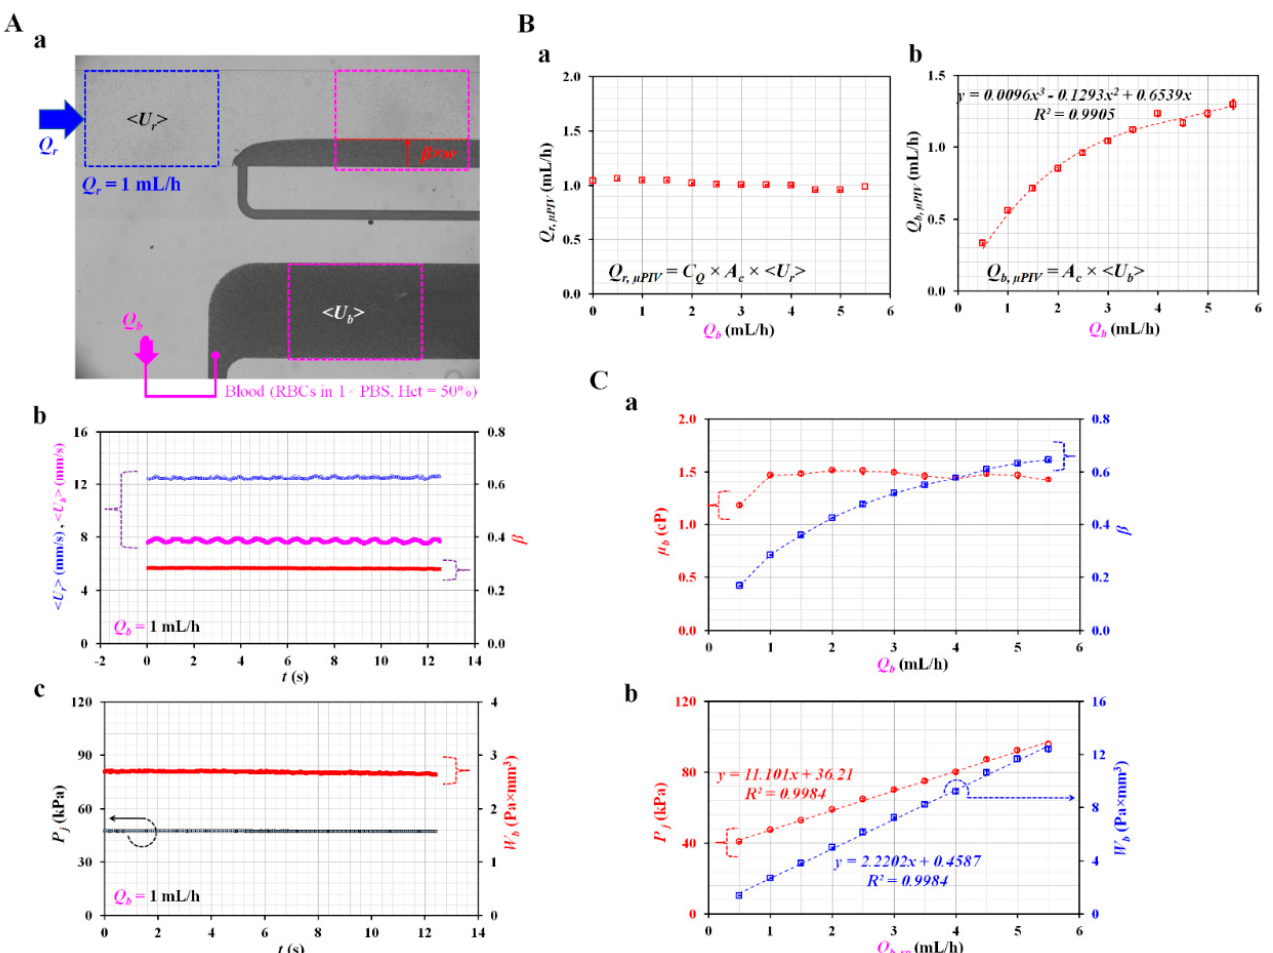
Figure A3. Quantification of three blood biophysical properties obtained by analyzing blood flows controlled with a syringe pump. ( A ) Quantification of junction pressure ( P j ) and pressure-induced work ( W b ) with three parameters. ( a ) Three parameters (i.e., < U r >, < U b >, and β ) for estimating µ b , P j, and W b of blood flows. ( b ) Temporal variations of < U r >, < U b > and β over time. ( c ) Temporal variations of P j as well as W b . ( B ) Quantification of flow rates ( Q r, µ PIV , and Q b, µ PIV ) obtained by conducting micro-PIV. ( a ) Variations of Q r, µ PIV with respect to Q b . ( b ) Variations of Q b, µ PIV with respect to Q b . ( C ) Variations of three blood properties with respect to the flow rate of the blood sample. ( a ) Variations of µ b and β with respect to Q b . ( b ) Variations of P j and W b with respect to Q b